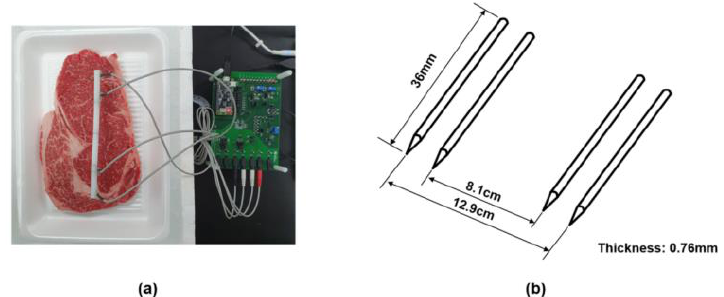
Figure 7. ( a ) Measurement setting; ( b ) schematic diagram of quadrupole electrode (reprinted from Ref. [20]).